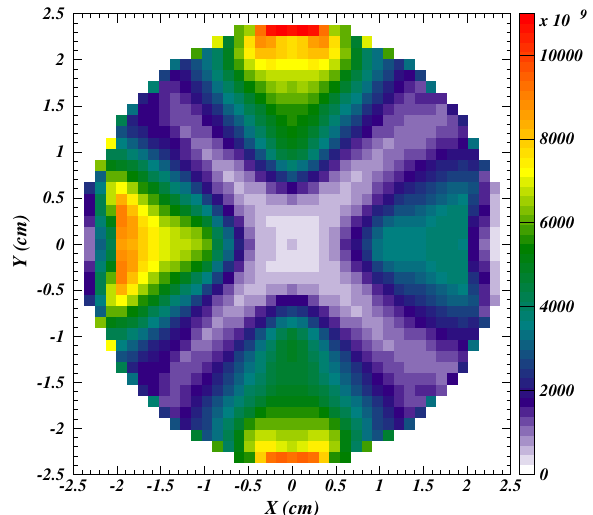
FIG. 11. Simulated EC density profile on a 41 × 41 grid in a quadrupole magnet in an arc region of the ILC CR averaged over the 2 . 2 μ s simulation time. Cloud electron escape zones are observed along the diagonal regions connecting magnet poles, as are several regions of trapped